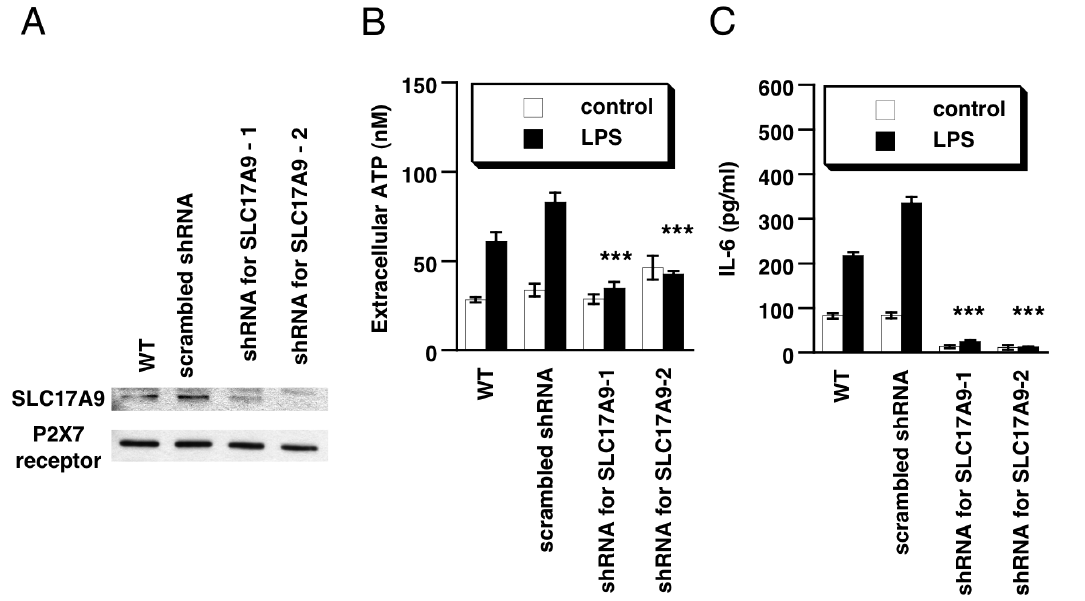
Figure 2. SLC17A9 is involved in LPS-induced ATP release and IL-6 production in THP-1 cells. ( A ) THP-1 cells were transfected with 2 m g of two different shRNAs targeting SLC17A9 (No. 1 or No. 2) or scramble shRNA. Seventy-two hours after transfection, cellular membrane proteins were extracted and the expression of SLC17A9 was detected by immunoblotting as described in Materials and Methods. ( B ) THP-1 cells transfected with two different shRNAs targeting SLC17A9 or the negative control shRNA were stimulated with LPS. At 10 min after LPS stimulation, the supernatants were collected and ATP content was measured (n=8–12). ( C ) The shRNA-transfected cells were incubated with LPS for 24 h, and then the concentration of IL-6 in culture medium was measured by ELISA (n=10–14). Each value represents the mean 6 SE. Significant differences between the control group (scramble) and the indicated group are indicated by ***(p , 0.001).